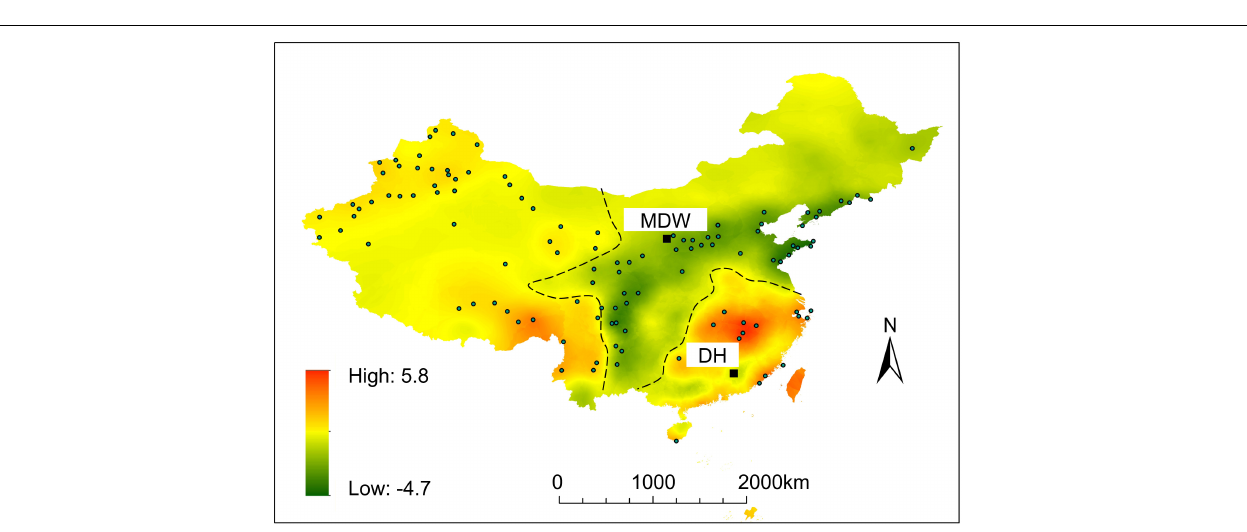
Frontiers in Earth Science |